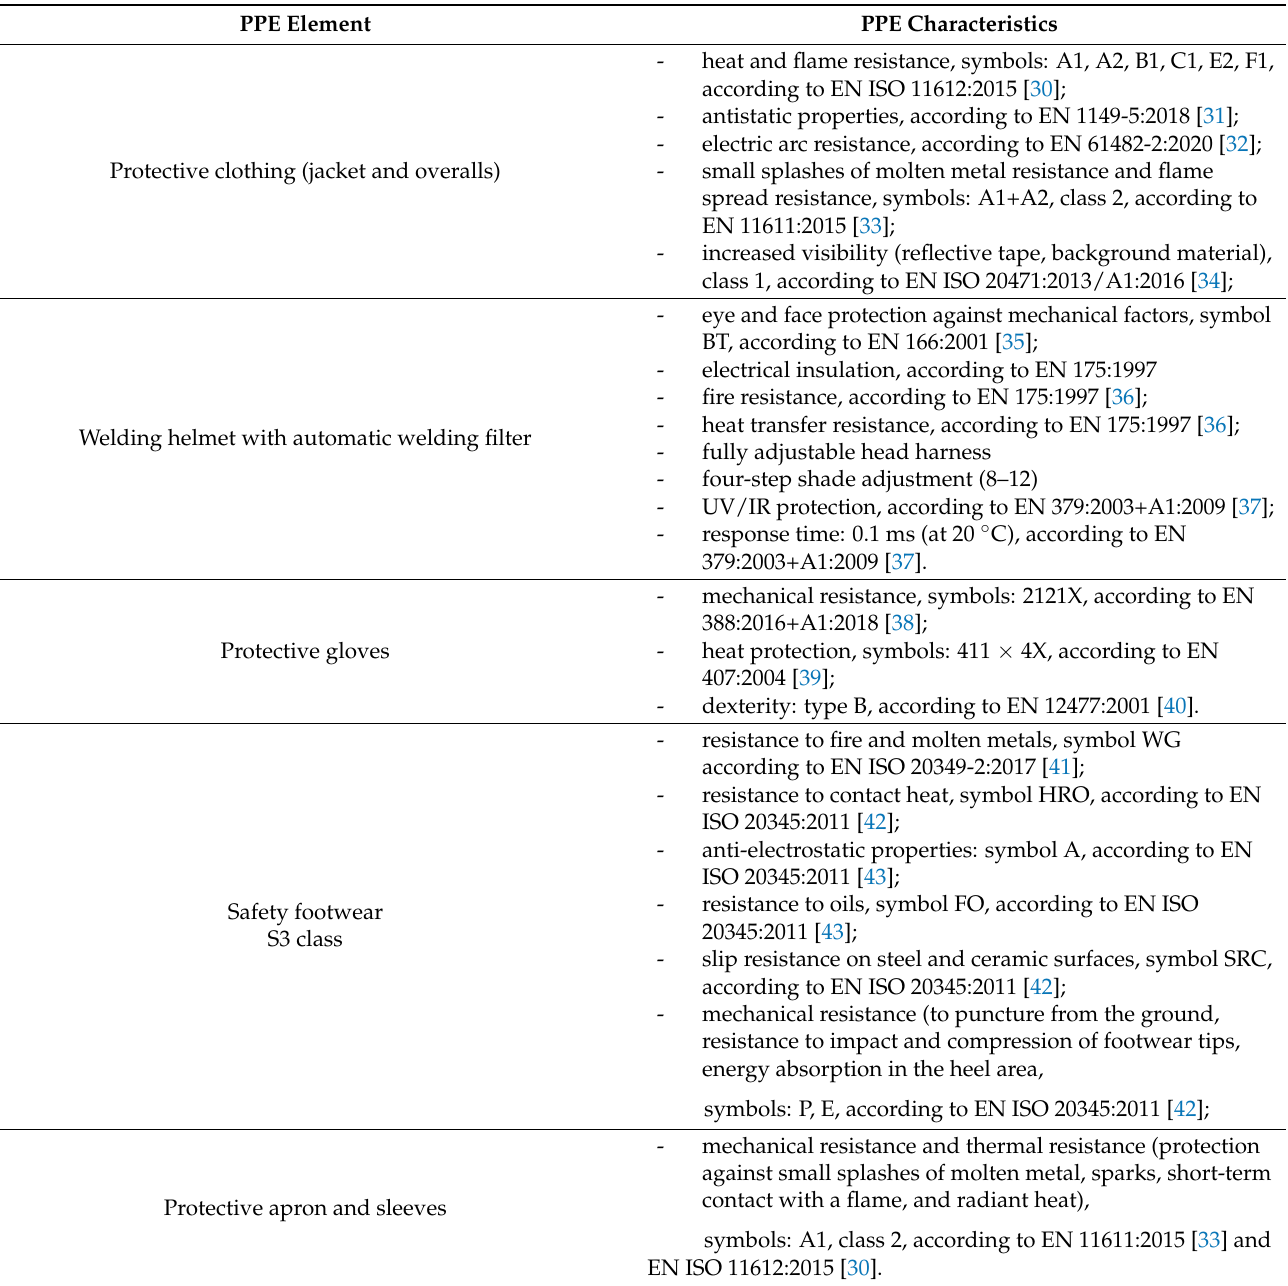
Table 1. Characteristics of the personal protective equipment used for tests. PPE Element PPE